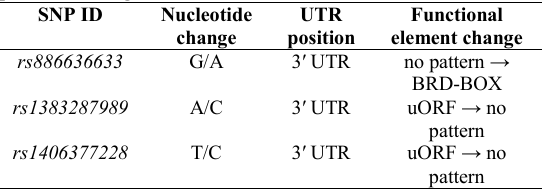
Table 6. SNPs in 3′UTR related to the functional pattern